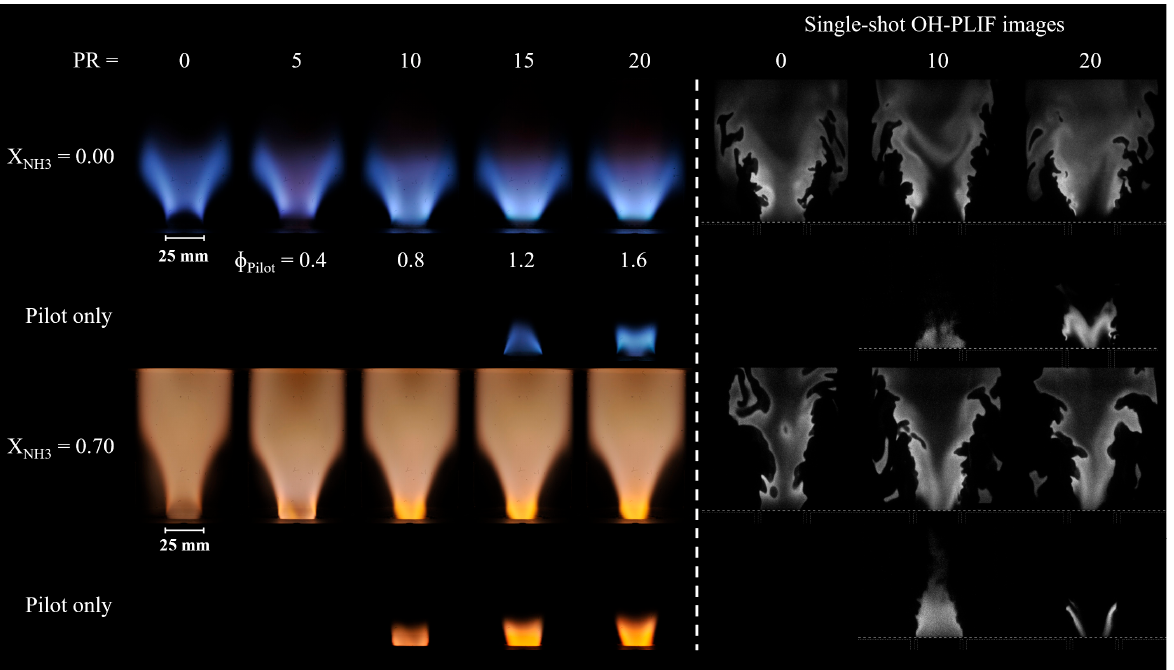
Figure 4. Time-averaged broadband ( left ) and OH-PLIF ( right ) images of CH 4 -air and NH 3 –CH 4 –air flames as a function of the pilot power ratio.